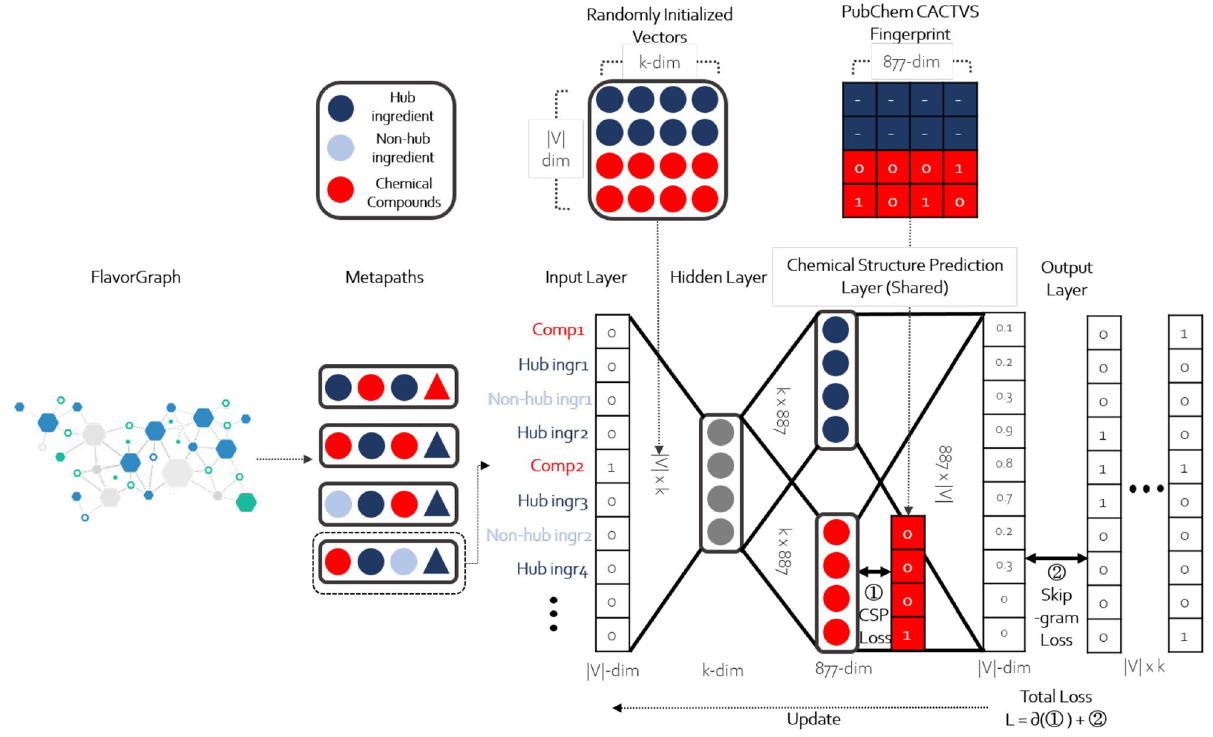
Figure 6. Graph Embedding with metapath2vec+CSP on